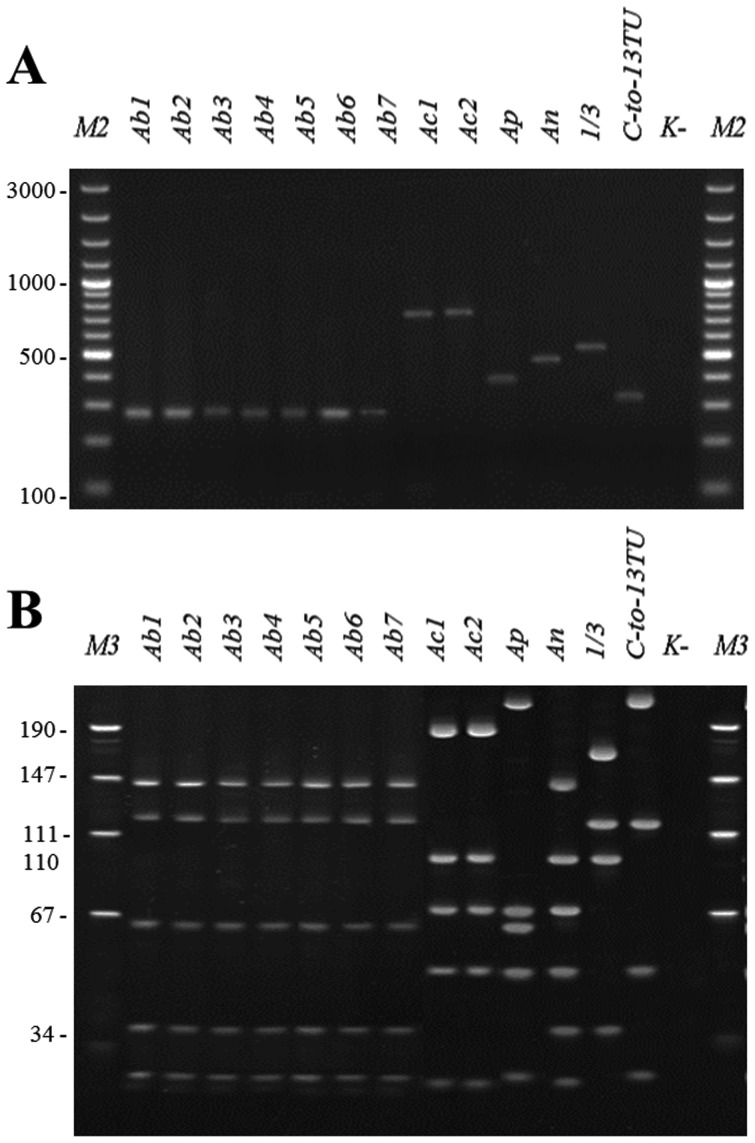
The results of Acb complex typing.(A) the 3′ recA-ddLMS PCR MaeII/RsaI, (B) PCR-RFLP/TspI typing of Acinetobacter calcoaceticus-baumannii complex. Ab1-Ab6 – A. baumannii strains; Ac1-Ac2 – A. calcoaceticus strains; Ap – A. pittii; An – A. nosocomialis; 1/3 – Acinetobacter gs. “Between 1 and 3”; C-to-13TU - Acinetobacter gs. “Close-to 13 TU” (Table 1). M2- the molecular DNA size marker (100-3000 bp); M3 - the molecular DNA size marker (pUC19/MspI); K-, the negative control (without DNA).